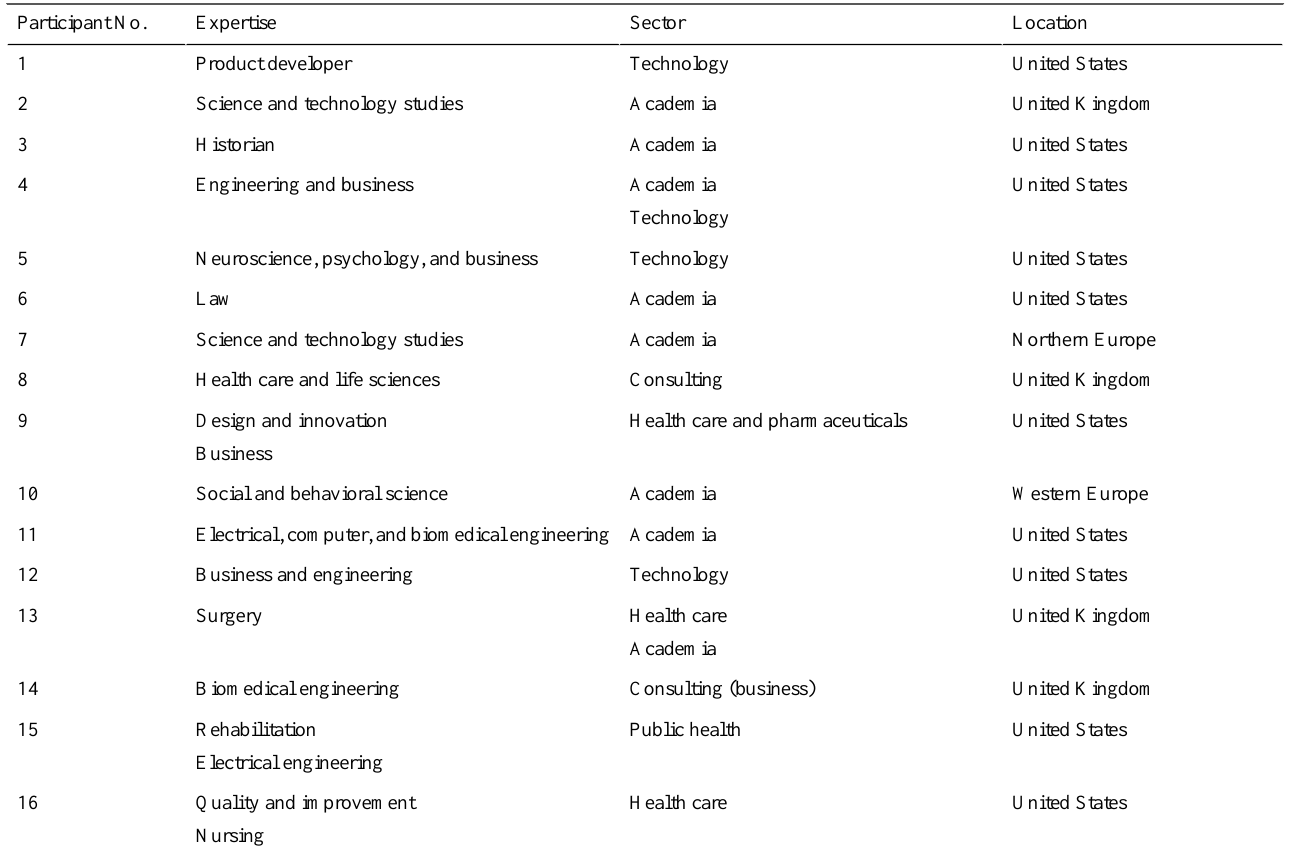
Table 1. Study participants’expertise, industries, and work locations. LocationSectorExpertiseParticipant